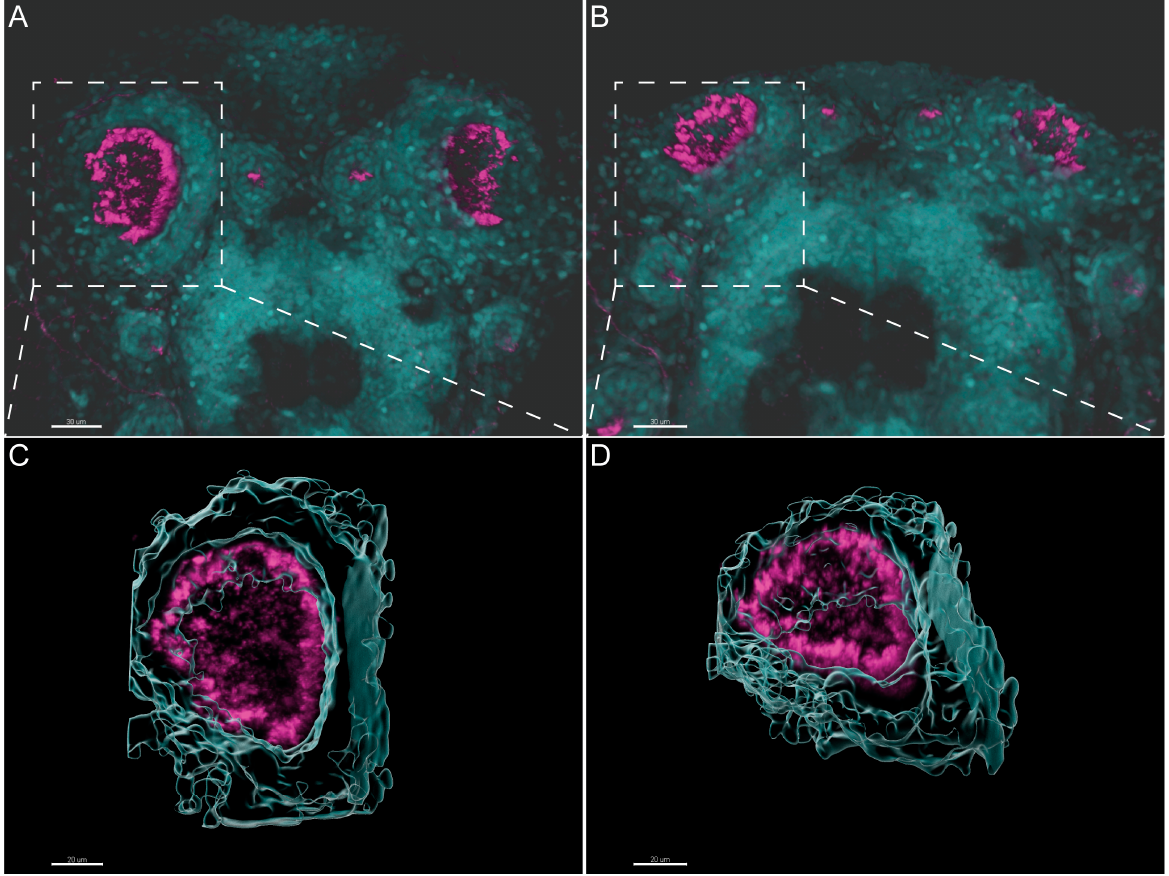
Figure 2. Three-dimensional imaging analysis helps to orient and localize the OP of zebrafish for TEM studies. ( A , B ). Immunofluorescent labelling with anti-acetylated α -tubulin shows the distribution of multiciliated cells in the OP of 4 dpf larvae. Software Imaris (Bitplane) v.9.5.0 allowed 3D blend reconstructions of 2 different OPs from 2 different larvae. ( C , D ) 3D surface reconstructions from the respective OPs revealing the concave morphology of the organ when rotated. Anti-Acetylated α -tubulin immunofluorescence in magenta and DAPI in cyan. Scale bar 20 μ m.